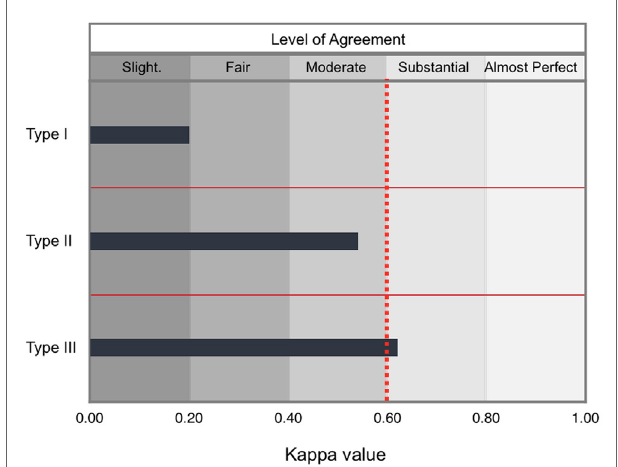
FigUre 1 | level of concordance among parents and urologists with regard to the level of satisfaction with surgical outcomes according to severity. Concordance on surgery satisfaction among parents and the pediatric urologist after hypospadias repair according to kappa scores was “slight” for Type I cases ( n = 52), “moderate” for Type II cases ( n = 21), and “substantial” for Type III cases ( n = 31). Ranges for kappa values for each level are shown. The dotted red line demarcates the target value that is minimum for substantial